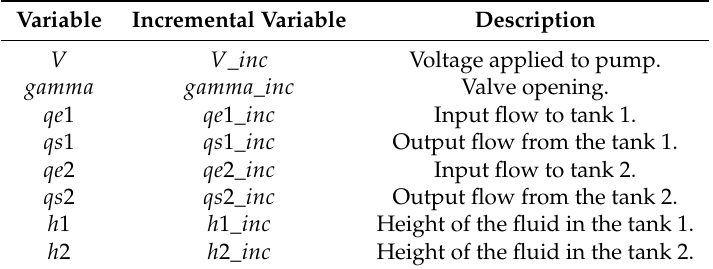
Table A8. Variables of the mathematical model (nonlinear and